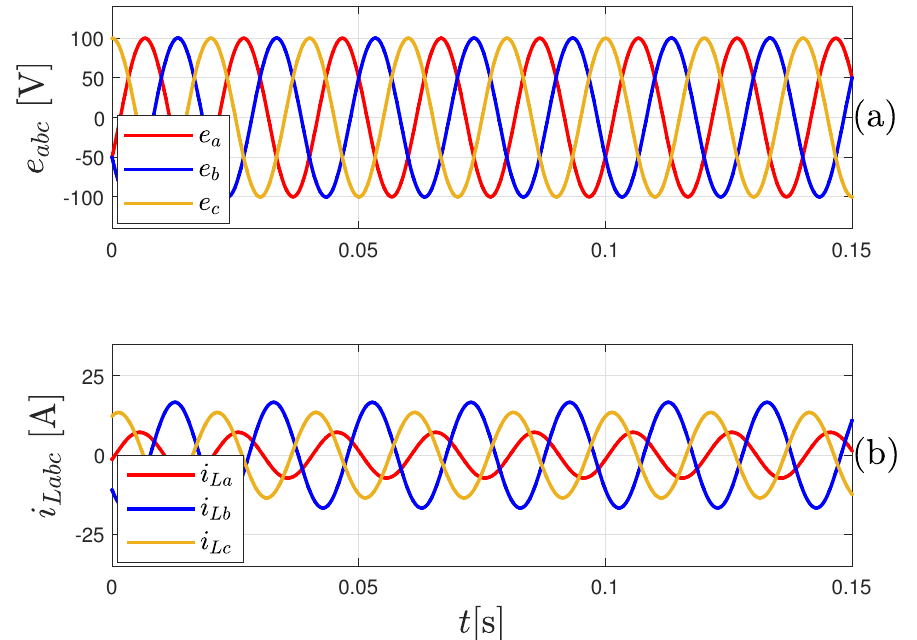
Figure 11. Test system behavior under very demanding conditions for the proposed controller (in red) and the classic PI approach (in yellow). ( a ) Voltage behavior in the Park’s reference frame. ( b ) Phase a voltage